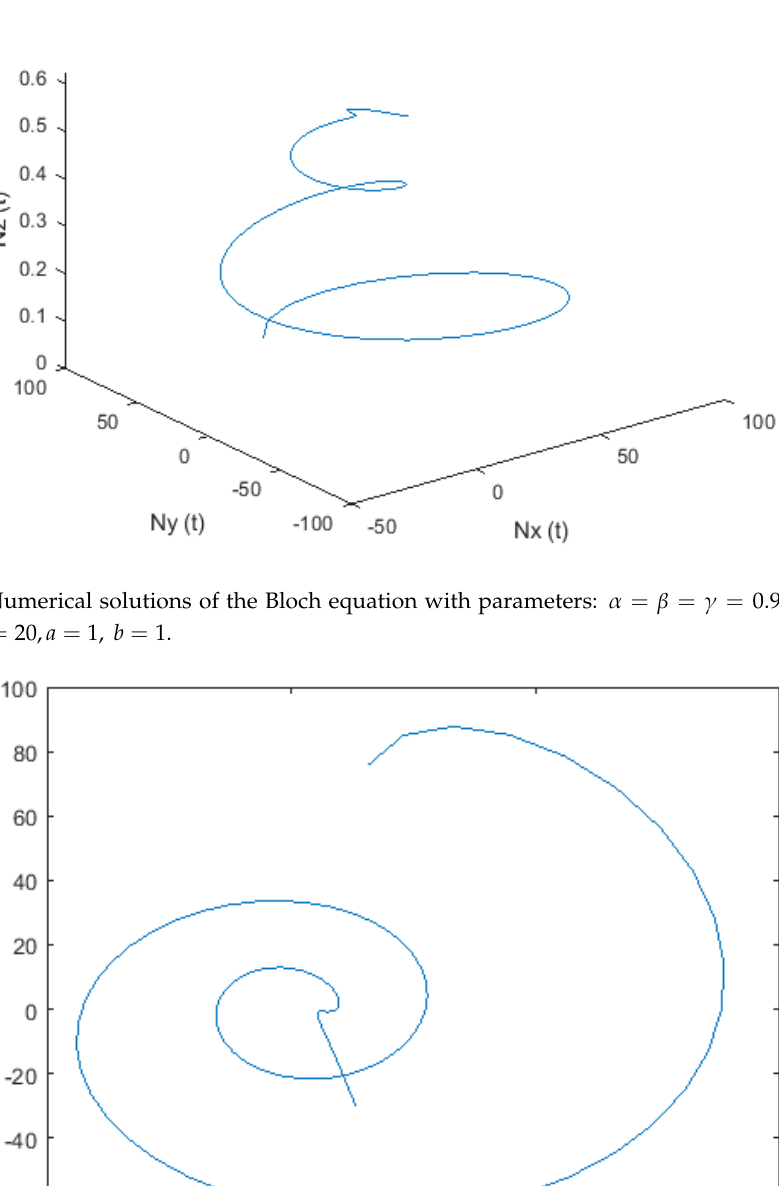
Figure 4. Numerical solutions of the Bloch equation in the plane (𝑁 (cid:3051) vs. 𝑁 (cid:3052) ) with parameters: 𝛼 = 𝛽 = 𝛾 = 0.9 , 𝑤 (cid:2868) = 12 , 𝑇 (cid:2869) = 1 , 𝑇 (cid:2870) = 20, 𝑎 = 1, 𝑏 = 1 .